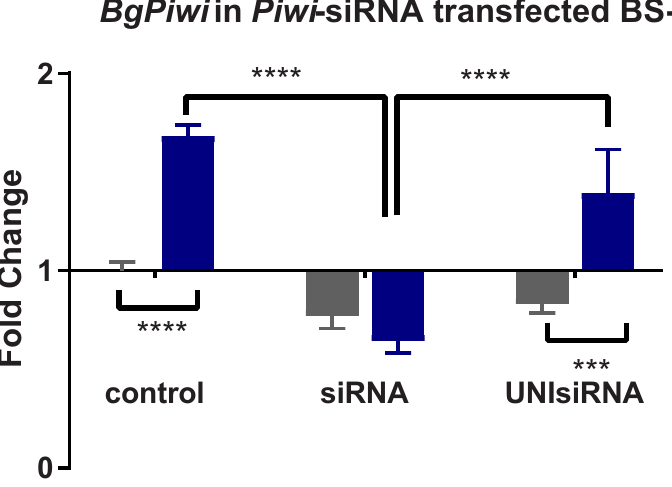
Fig 8. qPCR analysis of RNA from resistant BS-90 juvenile snails unexposed (gray) or exposed (blue) for 2hr to S . mansoni miracidia. Histograms show expression of the BgPiwi encoding transcript in normal BS-90 snails (control) or those transfected with BgPiwi siRNA. Note induction of the BgPiwi encoding transcript occurs in S . mansoni exposed control BS-90 snails and the knock down of the transcript in BS-90 (exposed and unexposed) snails transfected with BgPiwi siRNA. In BS-90 snails transfected with mock UNIsiRNA, note the upregulation of the BgPiwi encoding transcript in exposed snails similar to induction observed in control exposed snails. Fold change was determined as described in MATERIALS and METHODS. Significant expression normalized against expression of the myoglobin encoding transcript was measured by 2-way ANOVA and is indicated by number of asterixis on each histogram where ���� , indicates the most significant value p � 0.0001, ��� p � 0.001, �� p � 0.01, � p � 0.05, ns p >